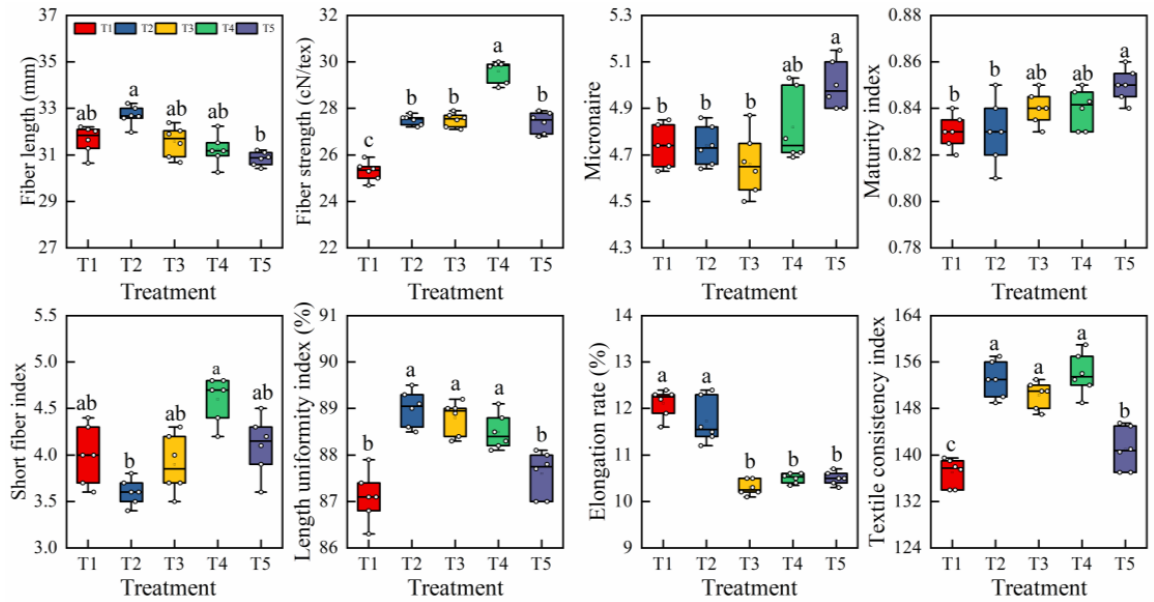
Figure 6. The cotton fiber quality for treatments. Different letters above the boxes indicate a significant difference at p < 0.05 according to the Duncan test.